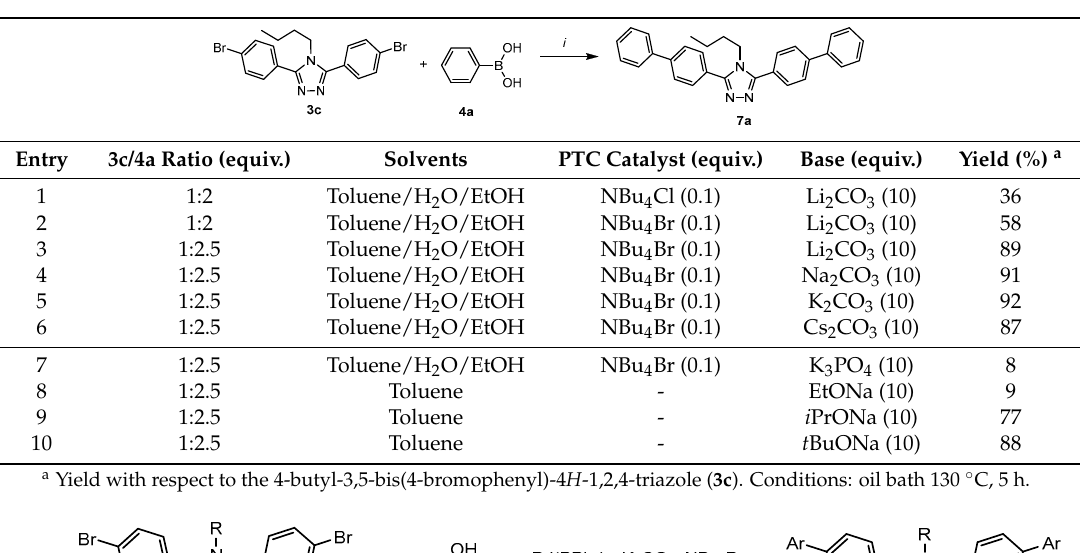
Table 2. The conventional Suzuki cross-coupling reaction for 3,5-bis(biphenyl-4-yl)-4-butyl-4 H -1,2,4- triazole ( 7a ).